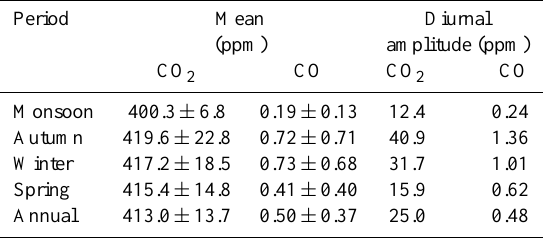
Table 5. Seasonal mean concentrations and diurnal amplitudes (max–min) of CO 2 and CO over